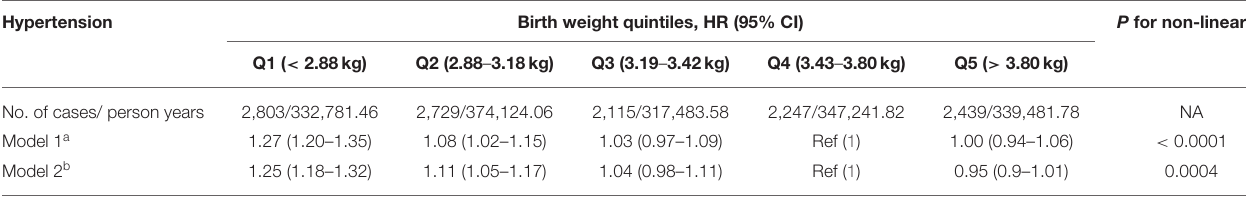
TABLE 2 | Associations between birth weight and hypertension.